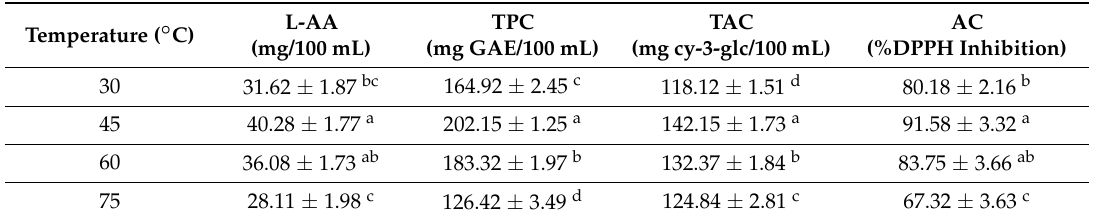
Table 5. L -ascorbic acid, total phenolics, total anthocyanin contents, and antioxidant capacities (mean ± SD) in mulberry juice at different sonicating